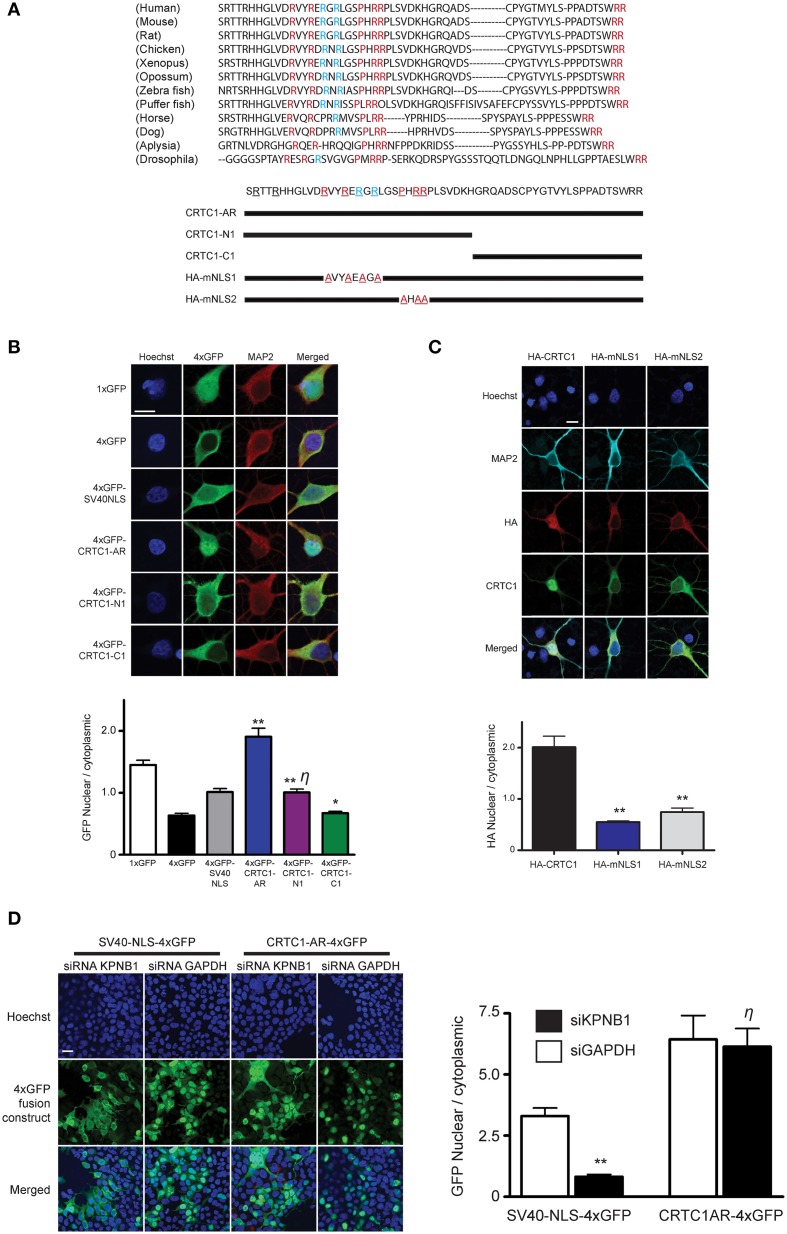
Characterization of CRTC1's arginine-rich NLS. (A) A 57 amino acid fragment (S92-R148) in CRTC1 with sequence identity (red) and similarity (blue) across species. Expression constructs described below. (B) As diagramed in (A), the full length arginine-rich fragment (CRTC1-AR) as well as CRTC1-N1, CRTC1-C1 and SV40NLS control fragment fused to 4xGFP were expressed in neurons. GFP signal in the nucleus and cytoplasm were quantified (**p < 0.001 relative to 4xGFP; * not significant relative to 4xGFP; η: not significant relative to SV40NLS). (C) Neurons expressing full length HA-tagged CRTC1 and alanine mutations in two arginine-rich clusters (HA-mNLS1 and HA-mNLS2, as diagramed in A) were stimulated with BIC and immunostained with antibodies against HA epitope (**p < 0.001 relative to HA-CRTC1). (D) HEK293T cells were treated with siRNA against KPNB1 (Importin β1) or GAPDH before being transiently transfected with SV40NLS-4xGFP or CRTC1-AR-4xGFP. The nuclear to cytoplasmic ratio of GFP was quantified (**p < 0.001 relative to siGAPDH; η: not significant relative to siGAPDH). Scale bars = 10 μm.